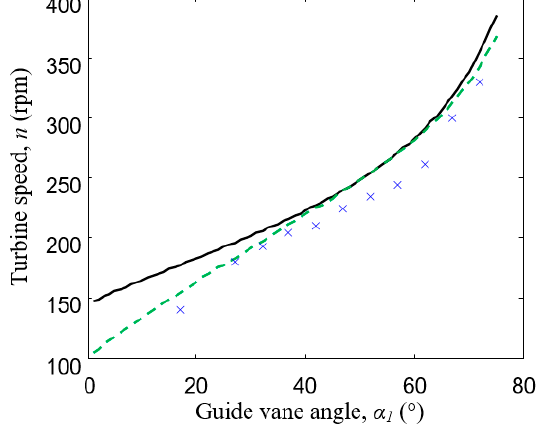
Figure 8. Optimal operation speed curve calculated (solid line—Formula (12), dashed line—Formulas (12) and (13)) and measured (crosses).